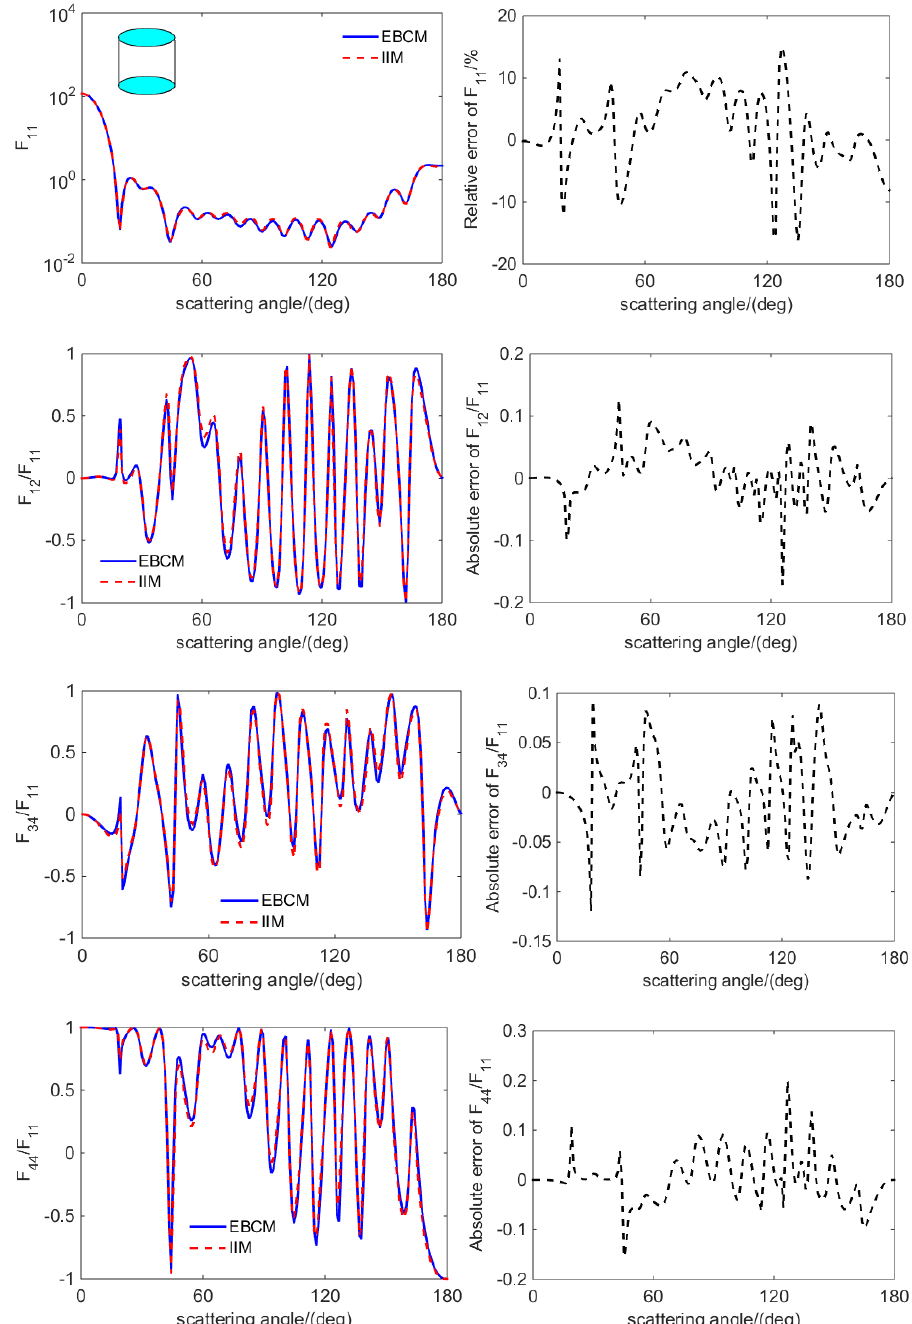
Figure 6. The scattering phase matrix obtained by the IIM and EBCM T-Matrix methods for cylindrical particles. The simulation errors of F 11 are denoted by relative errors. For F 12 , F 34 , and F 44 , they are firstly normalized by F 11 , and their simulation errors are evaluated by the absolute errors.